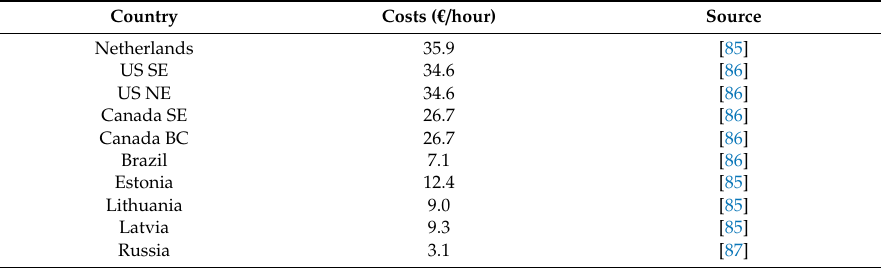
Table A3. Hourly labor costs in the manufacturing industry used in this study, in € / h. Country Costs ( € /